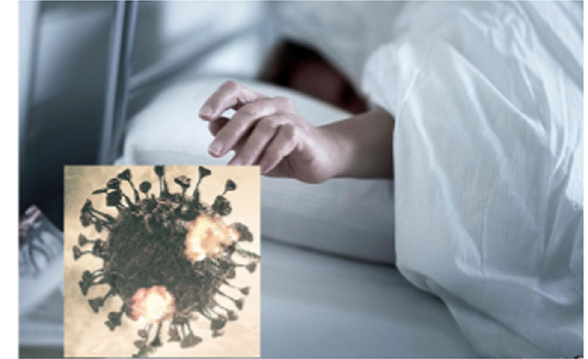
Fig. 10 Reframing: COVID AS ALARM CLOCK conceptual metaphor.